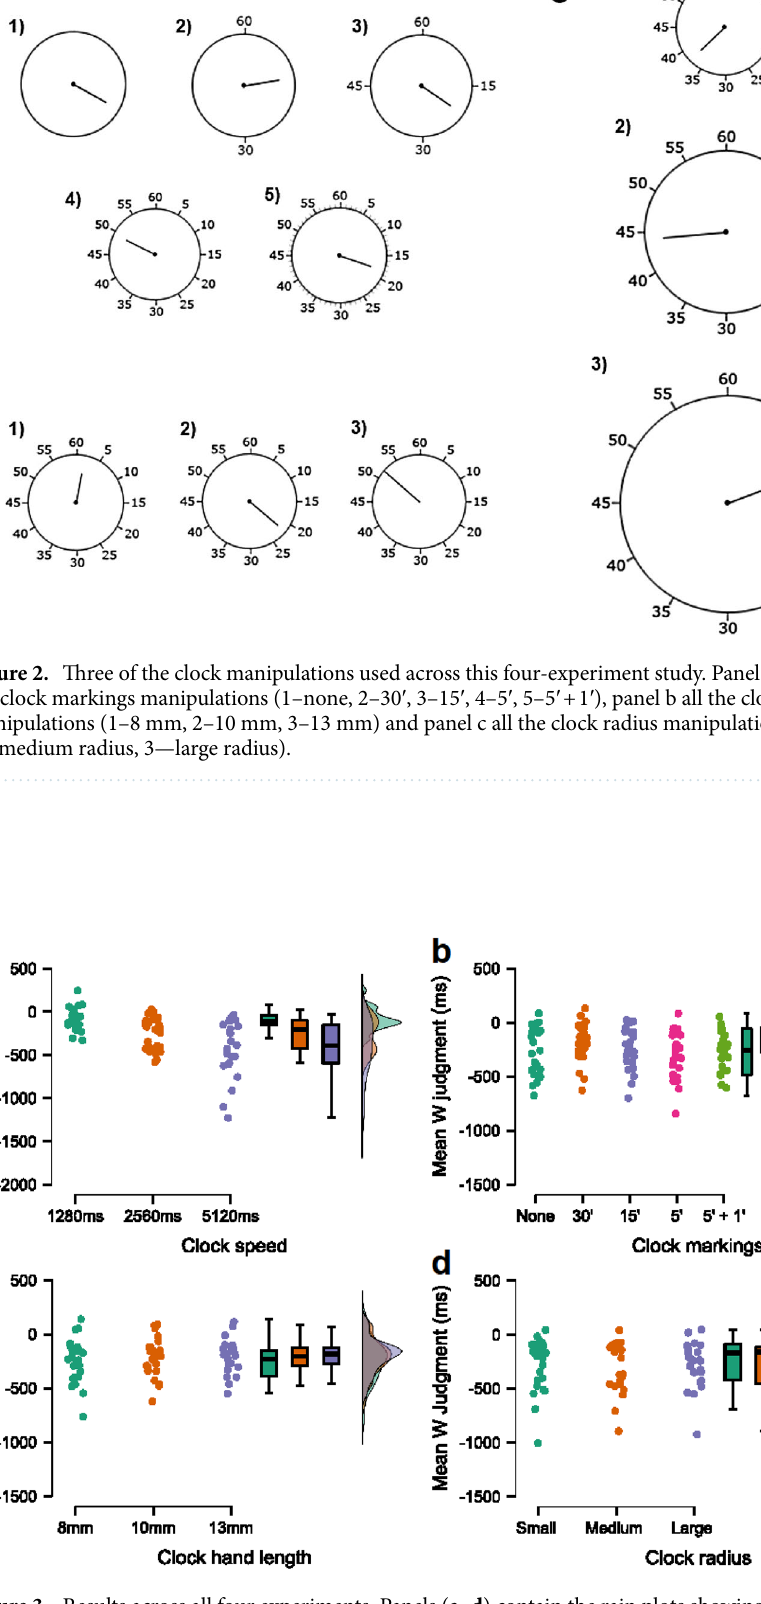
Figure 3. Results across all four experiments. Panels ( a – d ) contain the rain plots showing the results of the Clock speed, Clock markings, Clock hand length and Clock radius experiments,